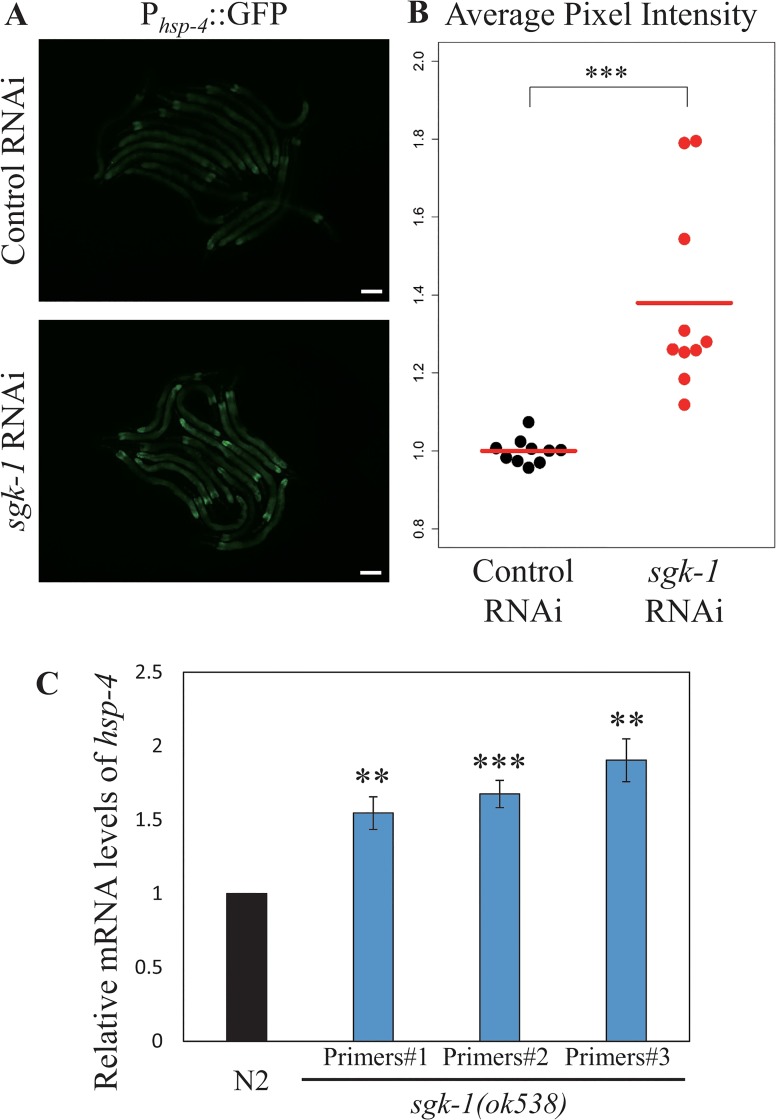
Loss of sgk-1 activity induced the UPR-ER.(A) Fluorescent images of worms carrying a GFP transgene under the hsp-4 promoter and treated with control RNAi (empty vector pL4440) or sgk-1 RNAi. Scale bars: 50 μm. (B) Quantitation of average pixel intensity of the images shown in (A) and 18 additional images, nine for control RNAi and nine for the sgk-1 RNAi. The average intensity is denoted with a red line. There were fifteen L4 worms in each image and ten images for each treatment. *** P value <0.001 (Student’s t-test). (C) Relative mRNA levels of hsp-4 in wild type and sgk-1(ok538) mutant animals. ** P value <0.01, * P value <0.05 (Student’s t-test).